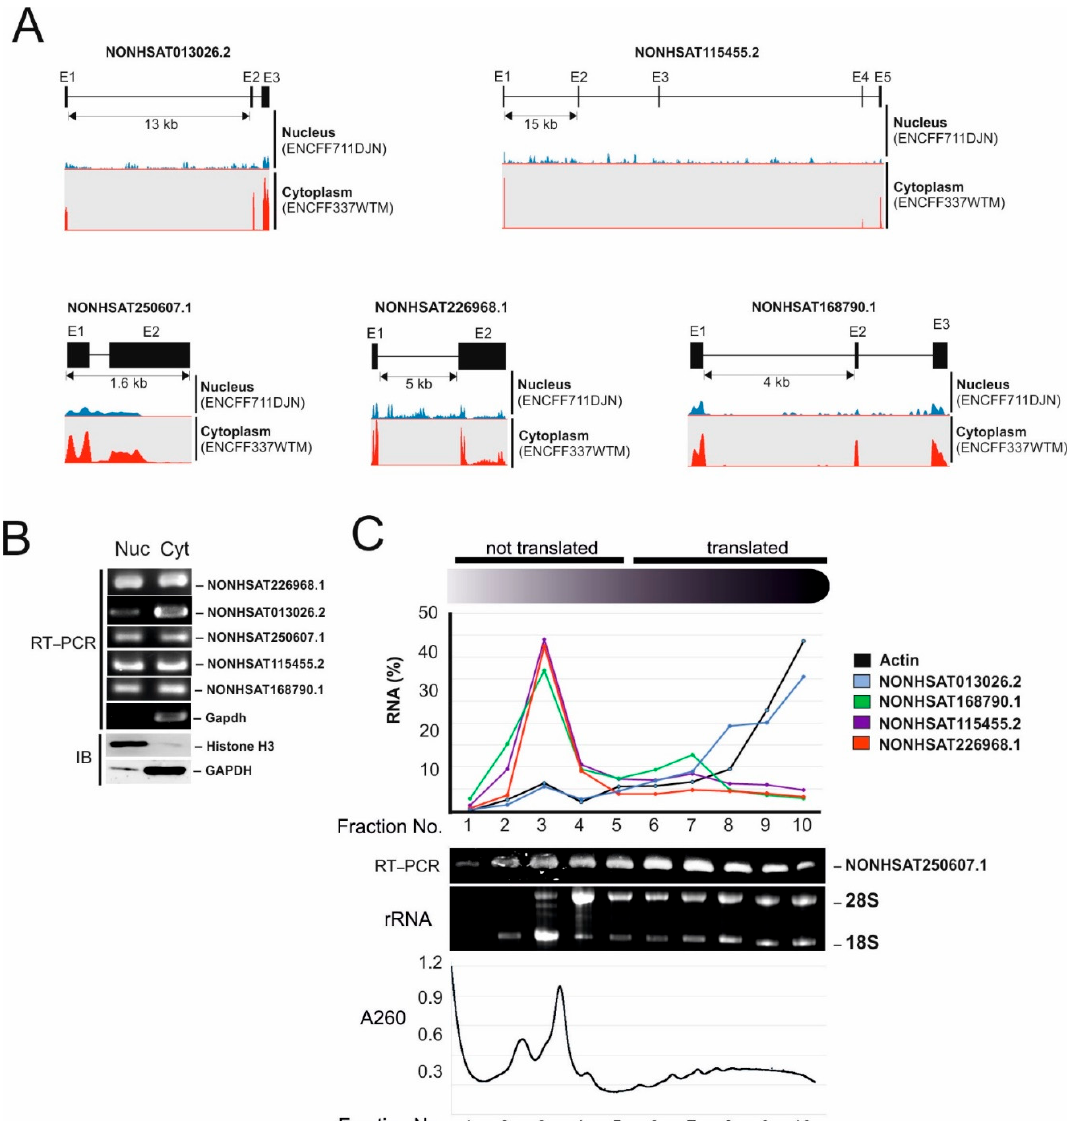
Figure 2. Identification of micropeptide candidates derived from HCC-specific lincRNAs. ( A ) Nuclear- (ENCFF711DJN) and cytoplasmic (ENCFF337WTM) RNA-seq of HepG2 cells generated by the ENCODE Consortium were aligned to the reference human genome (GRCh38). SeqMonk was used to quantitate and visualize the data. Peaks in the wiggle plot represent the normalized RNA-seq read coverage on HCC-specific lincRNAs. E: exon. ( B ) RNA was isolated from the nuclear (Nuc) and cytoplasmic (Cyt) fractions of HepG2 cells and analyzed by RT-PCR. Fractionation quality was measured by immunoblot analysis of THOC5, GAPDH and Histone H3 (Blot). Three independent experiments were performed. ( C ) HepG2 cytoplasmic lysate was prepared and fractionated on sucrose gradients. The distribution of RNA was calculated using the CT values obtained by qRT- PCR. Isolated RNA was supplied in a gel to determine translated fractions. mRNAs were prepared from the indicated fractions and were applied for Actin, NONHSAT013026.2, NONHSAT168790.1, NONHSAT115455.2, and NONHSAT226968.1 qRT-PCR or NONHSAT250607.1 RT-PCR. A represen- tative absorbance profile at 260 nm was obtained during fractionation of gradients. A replicate is shown in Figure